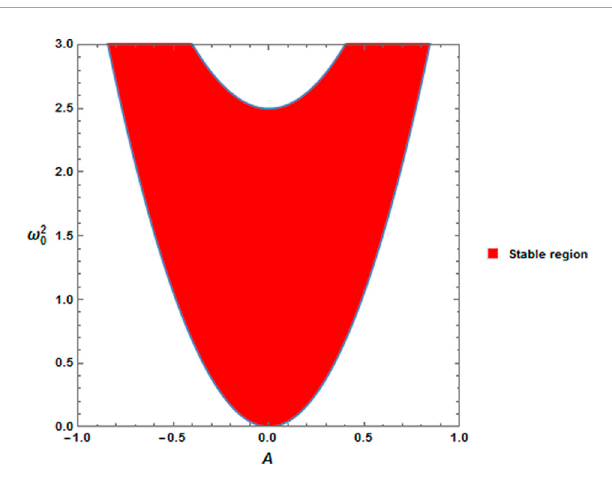
FIGURE 6 Stability distribution of the conditions for a system of R (cid:2) 2 and P (cid:2) 0 .